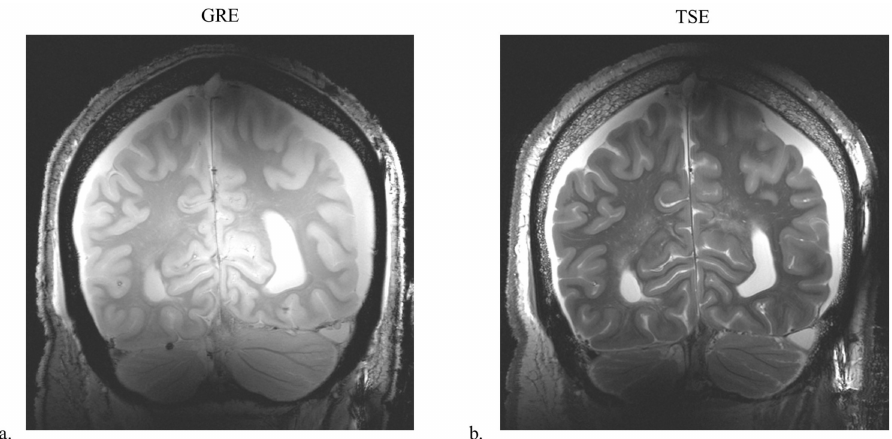
Figure 6. B 1 -phase-shimmed GRE ( a ) and TSE ( b ) images of the 8-channel sleeve antenna array with human cadaver in the coronal